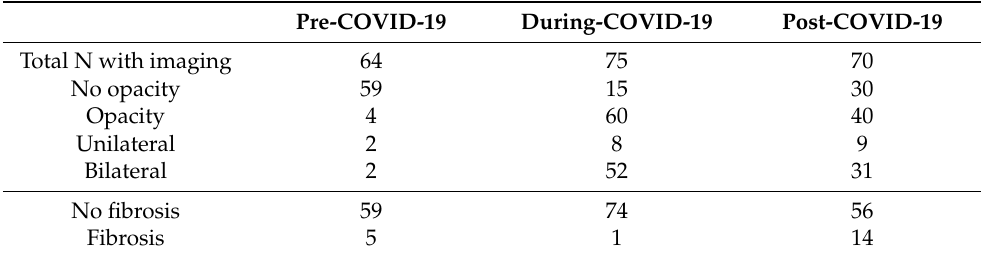
Table 5. Major lung imaging findings pre-, during and post-COVID-19 diagnosis. N reflects the number of unique patients. Post-COVID-19 average 5 months after diagnosis (N = 97). Pre-COVID-19 During-COVID-19 Post-COVID-19 Total N with imaging 64 75 70 No opacity